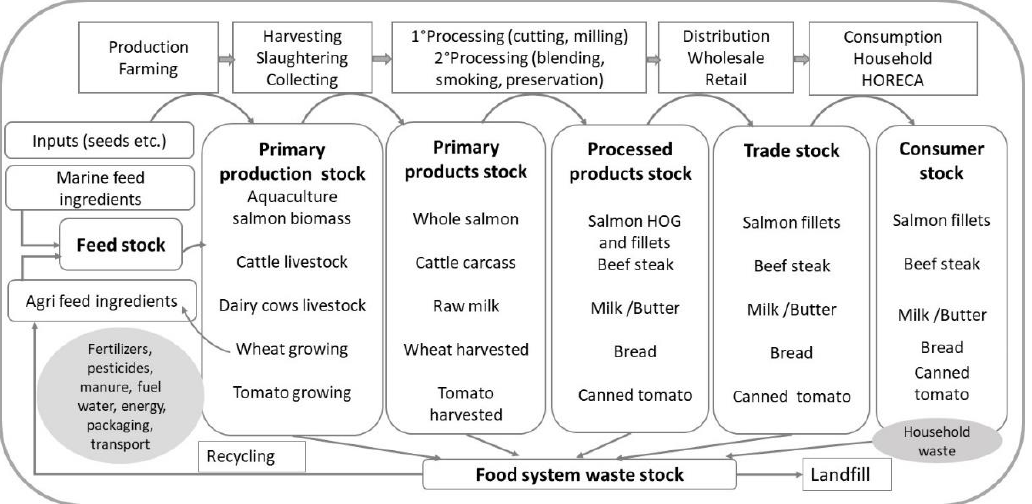
Figure 2. An overview of the food system approach demonstrating the key stages in food value chains and the associated flow of stocks for the food supply chains case studies in the VALUMICS project (adapted from [57]).